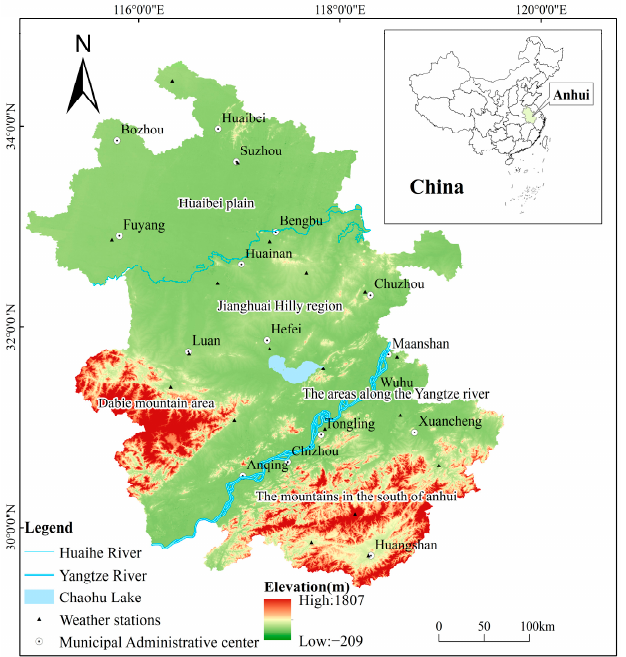
Figure 1. Geographical location and altitude of study area. The whole province is divided into five natural zones from north to south by Chaohu Lake, Yangtze River and Huaihe River: namely, Huaibei Plain, Jianghuai hilly area, Western Anhui mountainous area, area along the Yangtze River, and Southern Anhui mountainous area. The national meteorological stations and municipal administrative centers are shown in the figure.